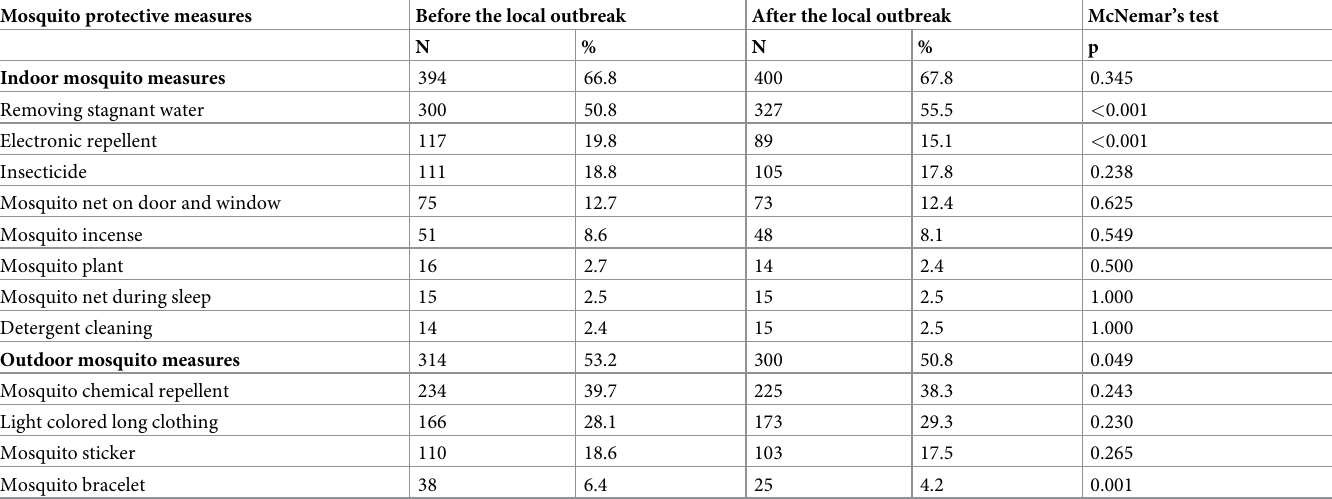
Table 3. Uptake rate of protective measures (N =